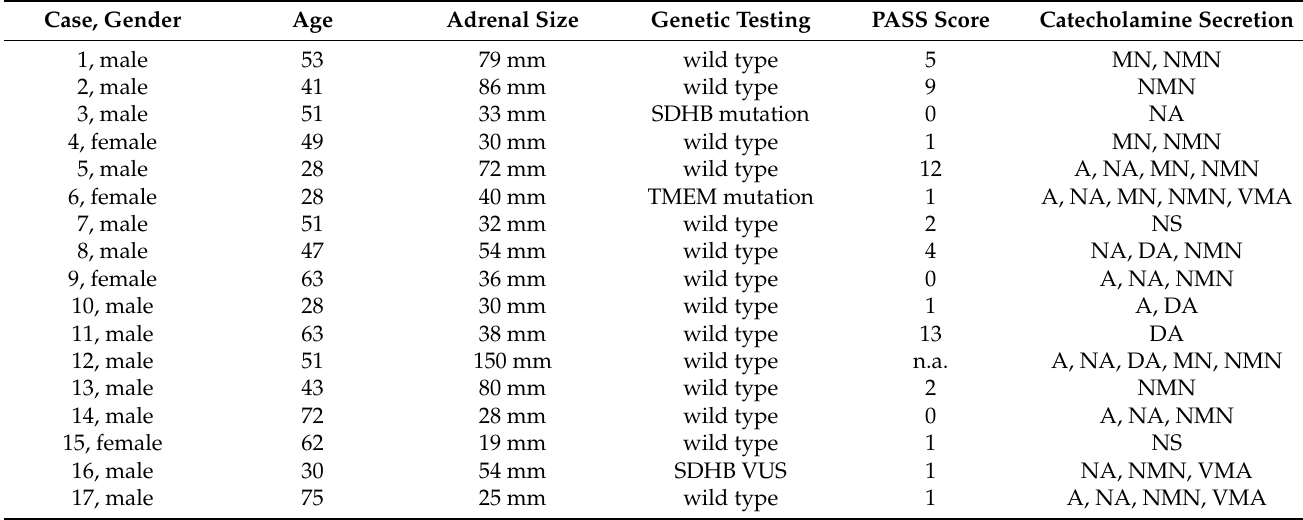
Table 1. Clinical data of the analyzed